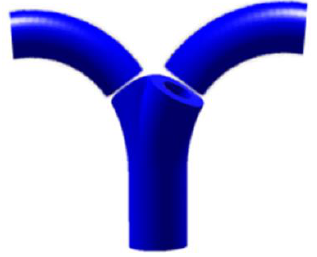
Figure 7. Fine decomposition result of the model.